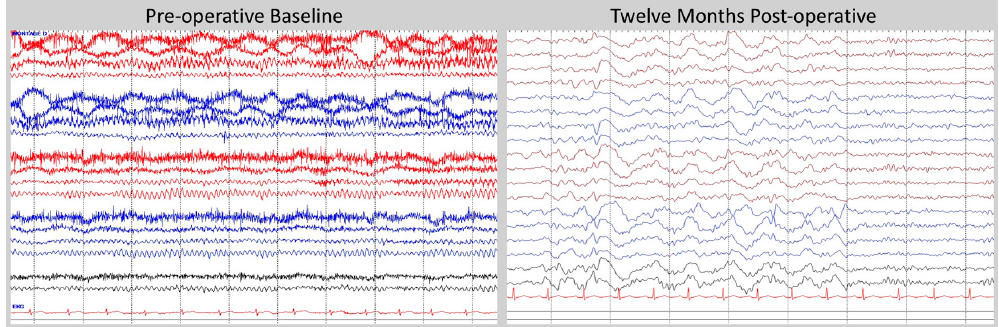
black. The tracings from top to bottom in sequence were: F p 2-F8, F8-T4, T4-T6, T6-O2, F p 1-F7, F7-T3, EKG tracing, which was in red color, was shown at the bottom.